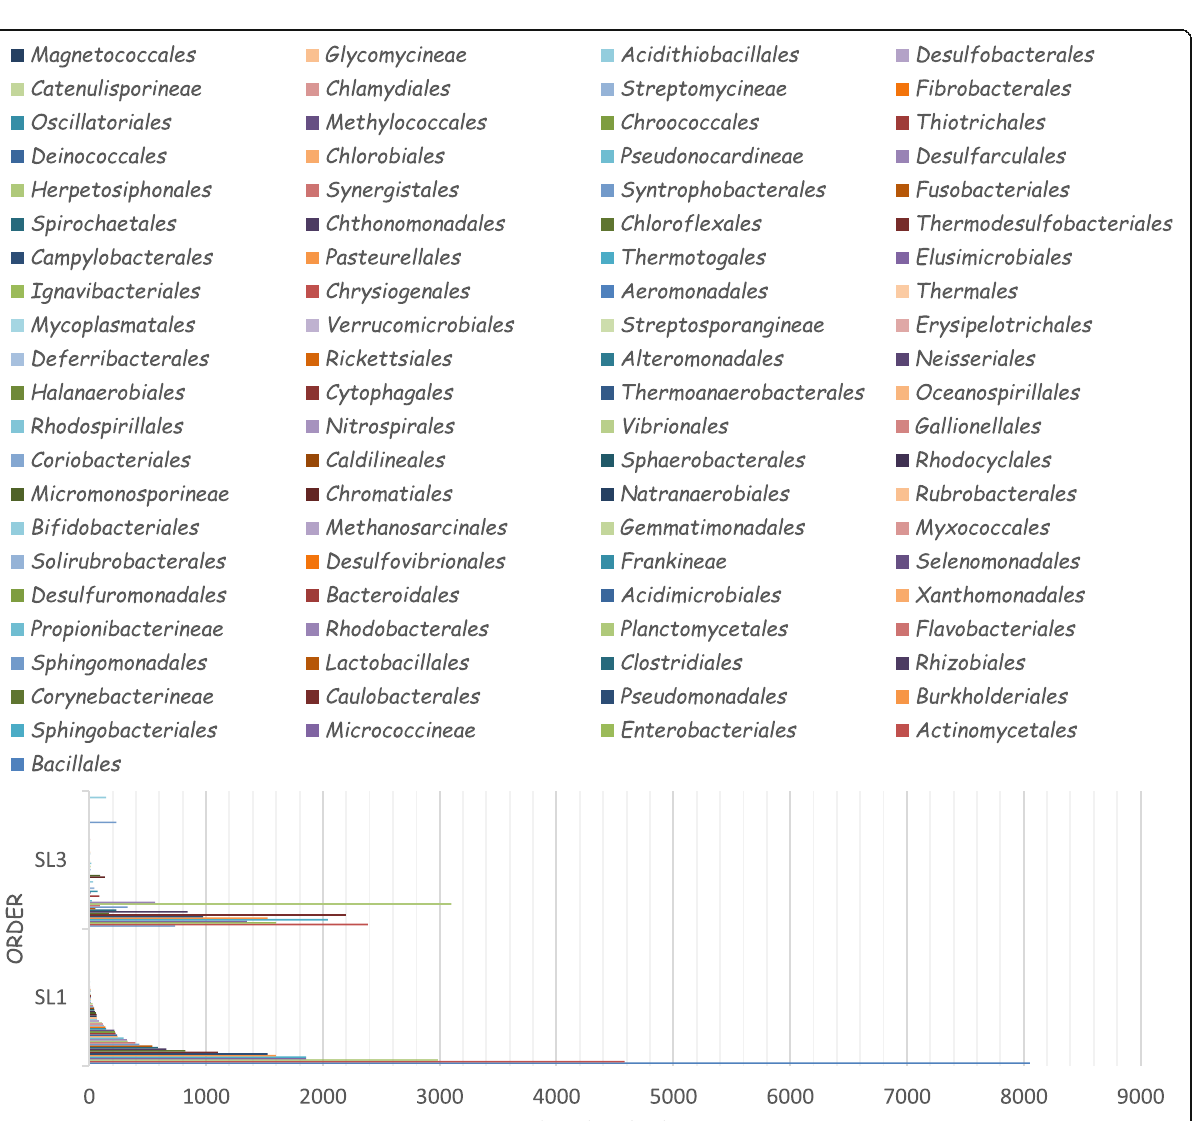
Fig. 3 Order classification of SL1 and SL3 metagenomes. Unclassified reads were not used for the analysis. All the orders detected in SL1 and SL3 metagenomes were